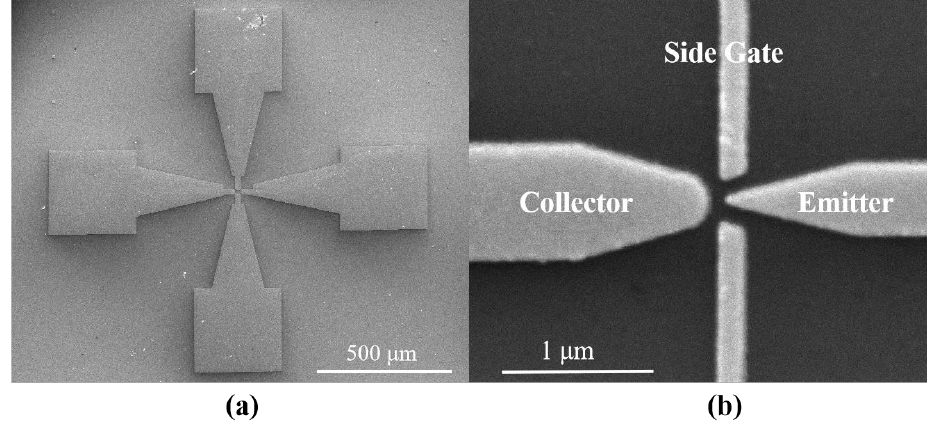
Figure 9. SEM images of ( a ) side-gate NVCT, ( b ) the zoom-in image of the nanoscale vacuum channel.